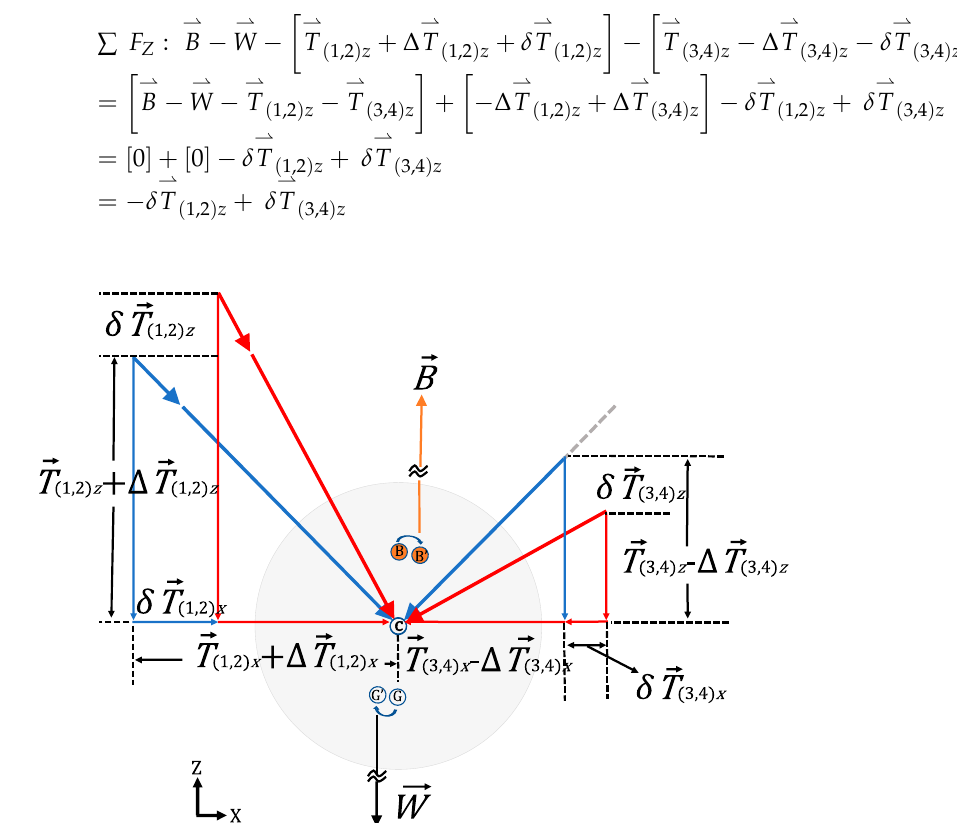
Figure 6. Case 2 (𝑡 + ∆𝑡) : Balanced thrust increase with resulting pitch. The body of the sphere rotates clockwise about G. The new position of the geometric center and center-of-buoyancy are denoted as C’ and B’, respectively. Note the changes to the corresponding thrust vectors. 𝑇(cid:4652)⃑ ((cid:2869),(cid:2870)) + ∆𝑇(cid:4652)⃑ ((cid:2869),(cid:2870)) is now less effective in generating + x translation and more prone to pushing the sphere down, while 𝑇′(cid:4652)(cid:4652)(cid:4652)⃑ ((cid:2871),(cid:2872)) has become less effective at pushing the sphere down and more effective at resisting + x translation. The change in forces, from the reference frame of the sphere, is given in Figure 7.